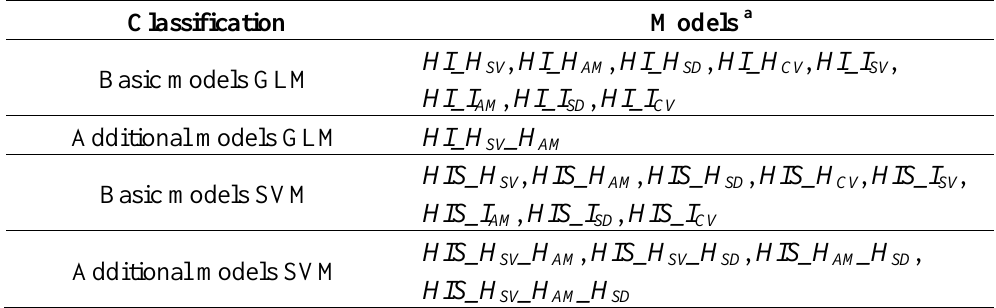
Table 3. Models used classification with GLM and SVM.